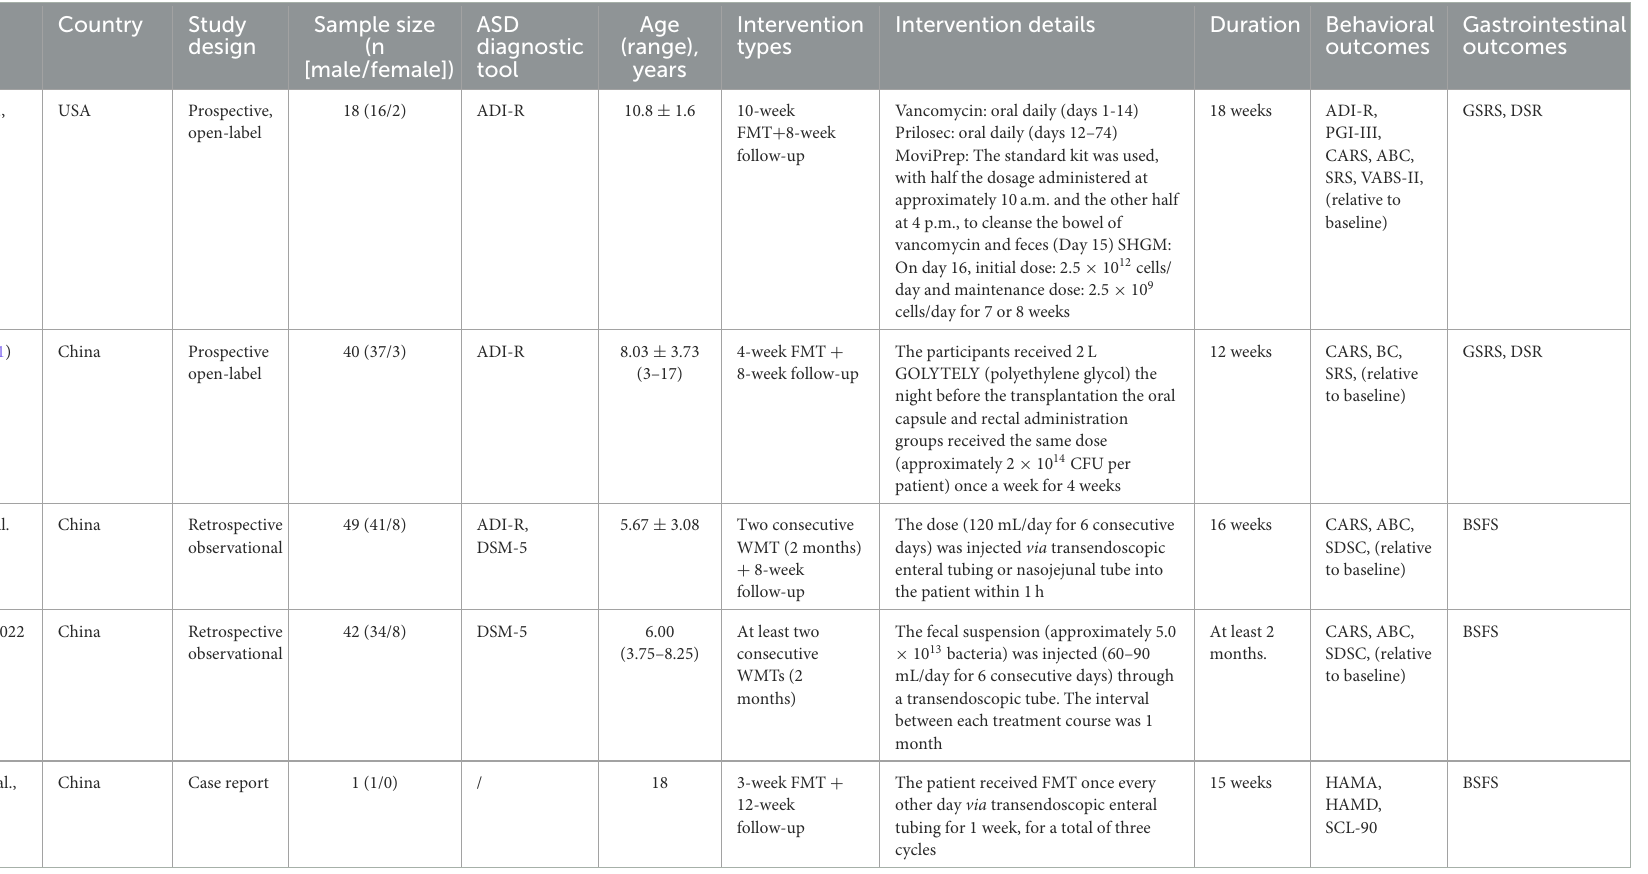
TABLE 1 Characteristics of the reviewed